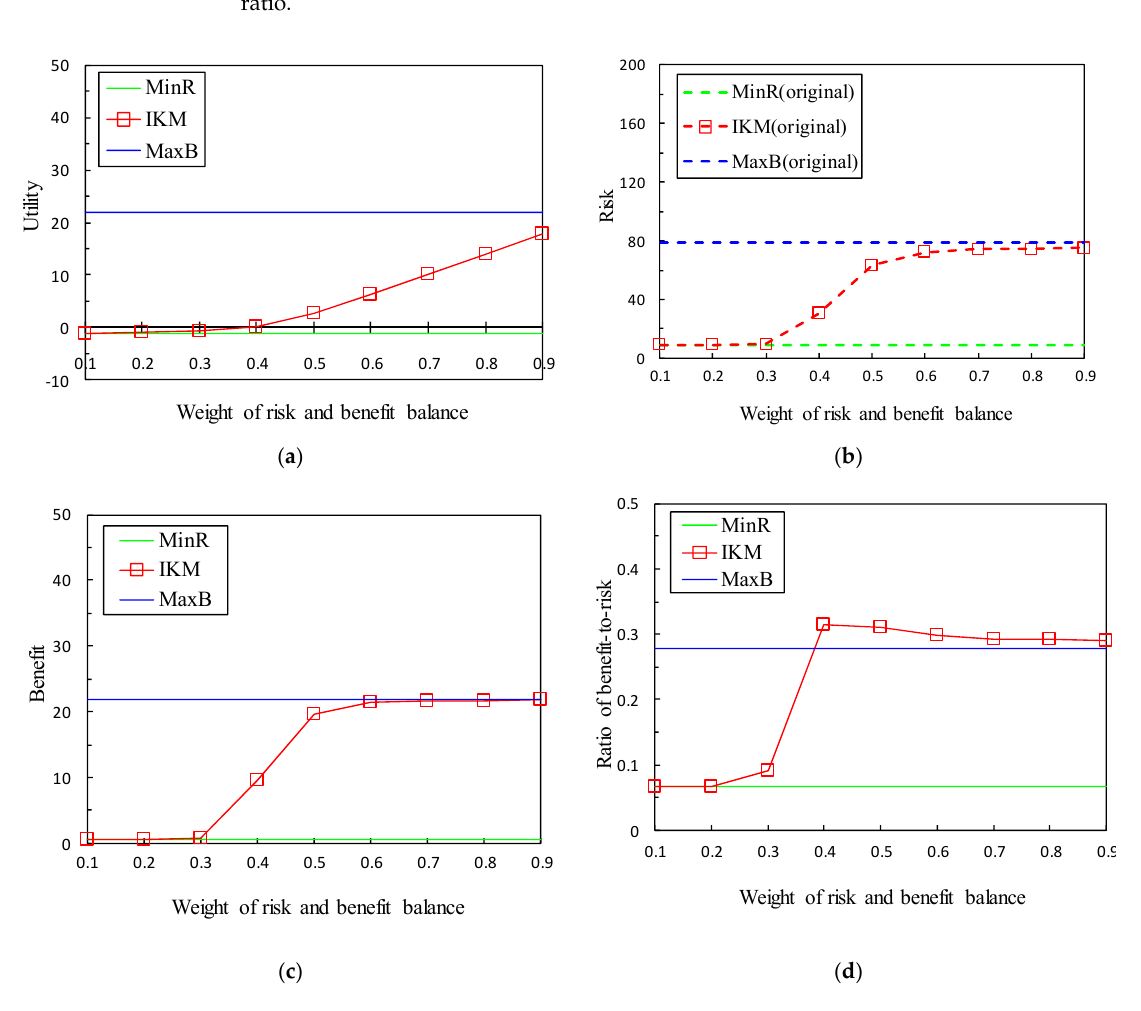
Figure 8. Effectiveness vs. weight of risk and benefit balance (Set #1.3). ( a ) Utility; ( b ) risk; ( c ) benefit; ( d ) benefit − to − risk ratio.